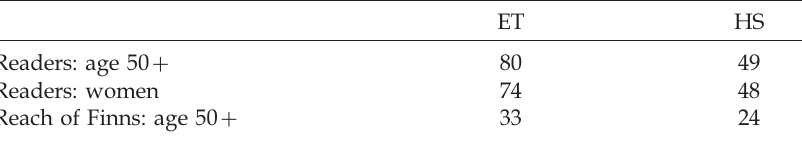
Table 1. Readers of the ET and the HS in 2007 (%)